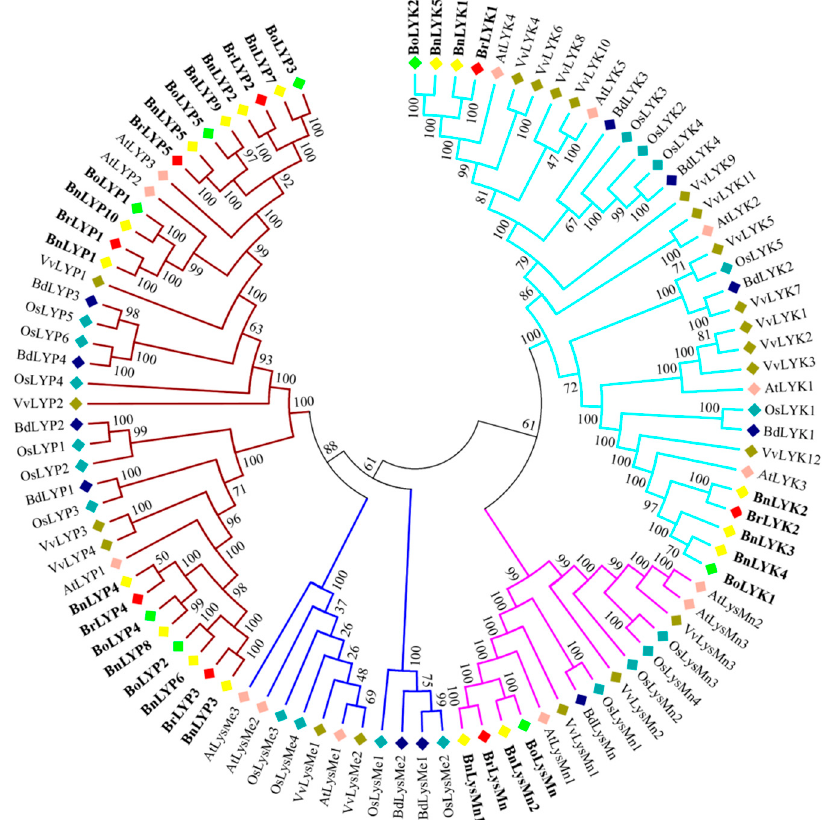
Figure 1. Phylogenetic relationships of LysM-RLK genes from Brassica napus (Bn), Brassica rapa (Br), Brassica oleracea (Bo), Oryza sativa (Os), Arabidopsis thaliana (At), Vitis vinifera (Vv), and Brachypodium distachyon (Bd). Colored branches have been used to depict various subfamilies. The phylogenetic dendrogram was constructed using MEGA 7 software and the neighbor-joining (NJ) method with 1000 bootstraps.